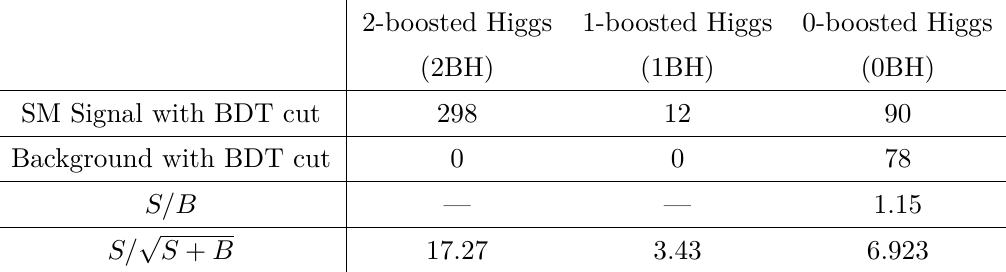
Figure 3 . The response of the discriminants to the SM signal and background at 100 TeV collider with (a) 2BH case, (b) 1BH case, and (c) 0BH case.